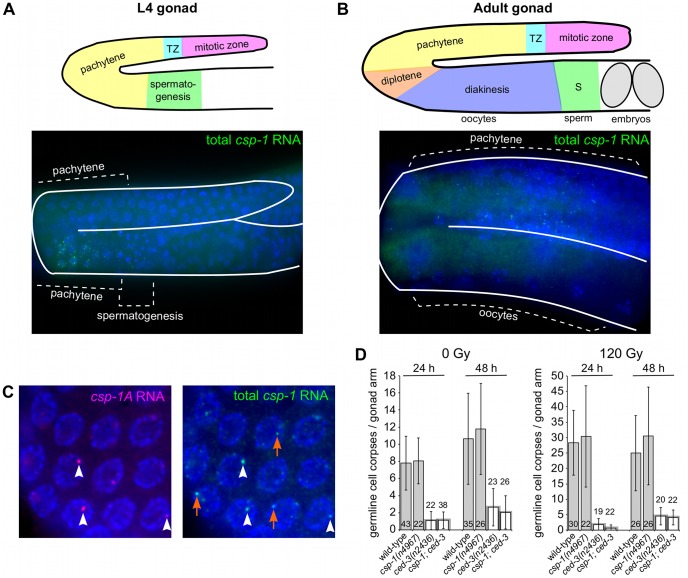

csp-1 is expressed in late pachytene cells of the L4 and adult hermaphrodite germline.Fluorescence in situ hybridization images of gonad arms of (A) an L4 hermaphrodite and (B) an adult hermaphrodite hybridized with Cy5-labelled probes complementary to csp-1B. The Cy5-labelled probes are visible as green puncta; the gonads are outlined in white. A schematic representation is shown above each micrograph. (C) Fluorescence in situ hybridization images of an adult hermaphrodite gonad hybridized with ALEXA594-labelled probes (red puncta) complementary to the region of csp-1A that encodes the prodomain (csp-1A) and Cy5-labelled csp-1B probes (green puncta) that hybridize to all csp-1 transcript isoforms (total csp-1). White arrowheads indicate csp-1A-specific puncta; orange arrows indicate csp-1B-specific puncta, which are recognized strongly by the total csp-1 probes but only weakly by the csp-1A-specific probes. (D) The number of CED-1::GFP-positive apoptotic cells in the gonads of caspase mutants exposed to 0 Gy and 120 Gy of ionizing radiation at the L4 larval stage. The strains were scored at 24 hrs and 48 hrs post L4-stage. Error bars indicate standard deviations.